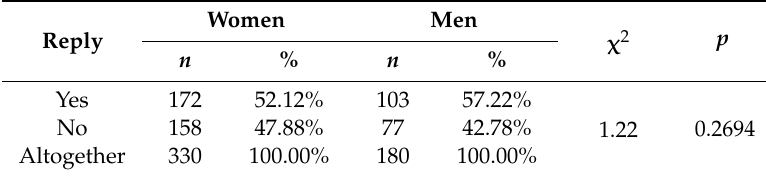
Table6. StudyaboutthemotivationtoparticipateinthePoznanHalfMarathoninthefuture—depending on sex.